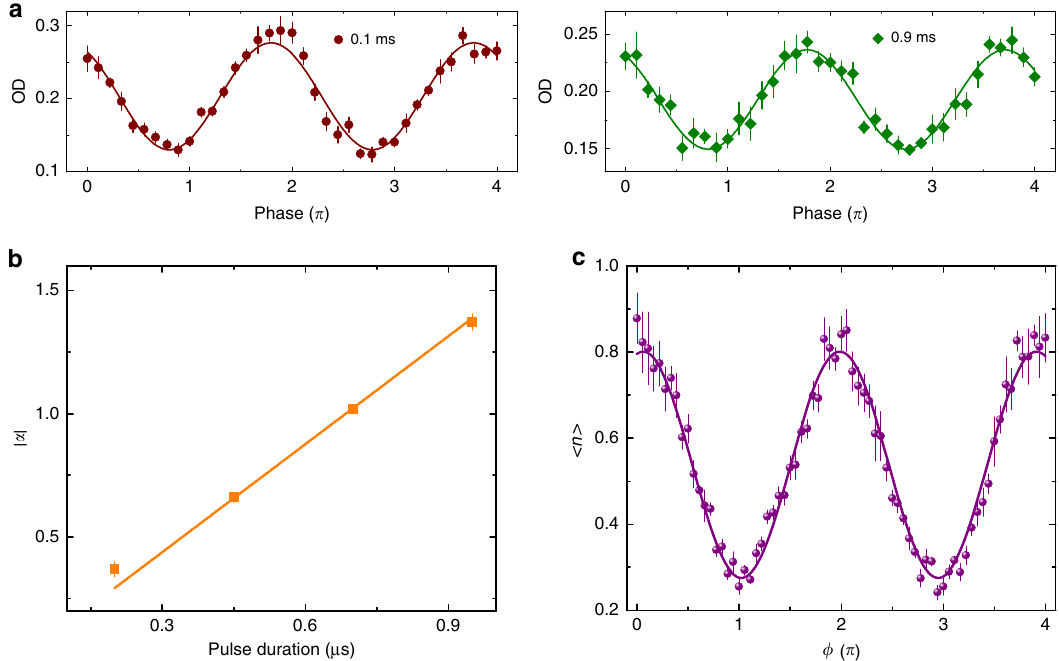
Fig. 3 Preparation of a quantum coherent harmonic oscillator state. a Coherence time measurements between | ↓ , n > and | ↑ , n − 1> states. A π /2 – π – π /2 spin-echo sequence is implemented on the atoms before sideband cooling. The duration of the π /2 laser pulses is 7.5 μ s. The OD of | ↑ , n − 1> is measured with the varying phase of the fi nal π /2 laser pulse. Error bars are the standard error of the mean of four experimental runs. The curves are sinusoidal fi ts to the data. b Measurements of the amplitude of the coherent state as a function of driving lasers pulse duration, where atoms are initially prepared in | ↓ > state. We determine the amplitude of the coherent state by measuring < n > with vibrational spectroscopy, similar to Fig. 2b. Each data point corresponds to one vibrational spectroscopy measurement. Error bars are the standard error of mean of four experimental runs. The straight line is a linear fi t to the data with a fi xed intercept at zero. c Measurements of < n > of a coherent state after two consecutive driving lasers pulses with phase difference ϕ . The coherence of Fock states components in the coherent state is examined by applying two consecutive driving lasers pulses with phase difference ϕ . After the two driving lasers pulses, we measure < n > from the vibrational spectra and plot it for different phases between the fi rst and second displacement pulses. Error bars are the standard error of the mean of four experimental runs. The curve is a sinusoidal fi t to the